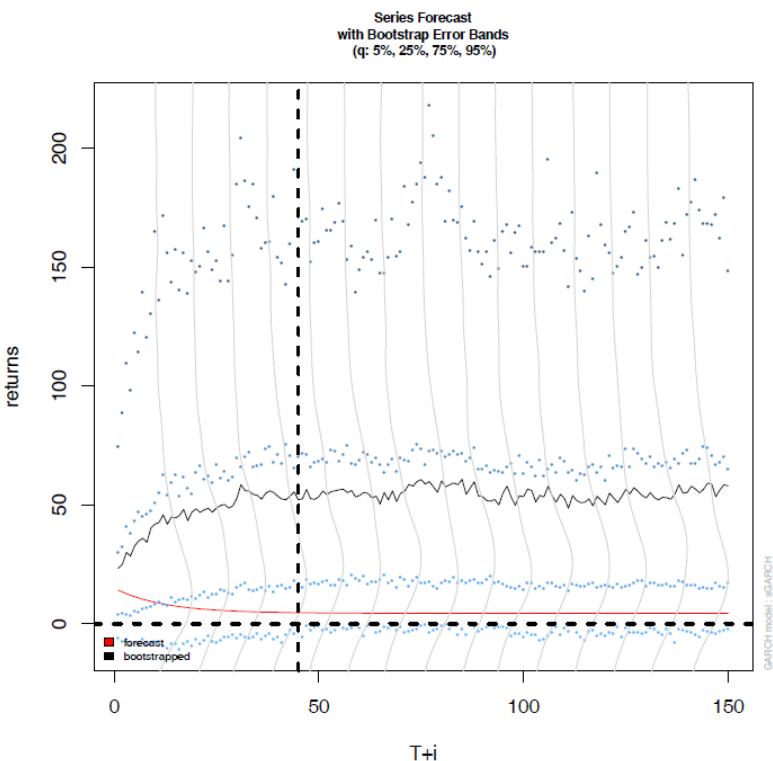
Figure 5. Change in number of native plant species described over time in South Africa. This means that, on average, 35 species are annually described. The GARCH model predicts that it would take 45 years for all remaining species in South Africa to be described (Figure 6). This implies that, if the current description rate is maintained (35 species/year), in those 45 years, 1575 species would have been described (i.e., it remains potentially 1575 species still to be described).